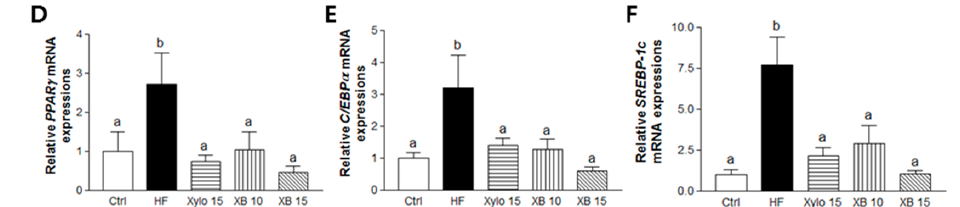
Figure 4. Effects of XB on lipid accumulation and lipogenesis in the liver. ( A ) Liver weight (g); ( B ) Liver triglyceride content (mg/g). ( C ) Hepatic histopathologic features ( a ) Ctrl; ( b ) HF; ( c ) Xylo 15; ( d ) XB 10; and ( e ) XB 15. Magnification × 200; ( D – F ) Real-time PCR results of adipogenesis and lipogenesis-related genes expression in the liver. The values presented are the mean ± SEM and all of the data were analyzed with one-way ANOVA and Newman-Keuls’ post hoc test. The superscript letters indicate significant differences ( p < 0.05). PPAR γ , peroxisome proliferator-activated receptor gamma; C/EBP α , CCAAT/enhancer binding protein alpha, SREBP-1c , sterol regulatory element-binding protein 1; Ctrl, control mice that received the AIN93G diet; HF, obesity control mice that